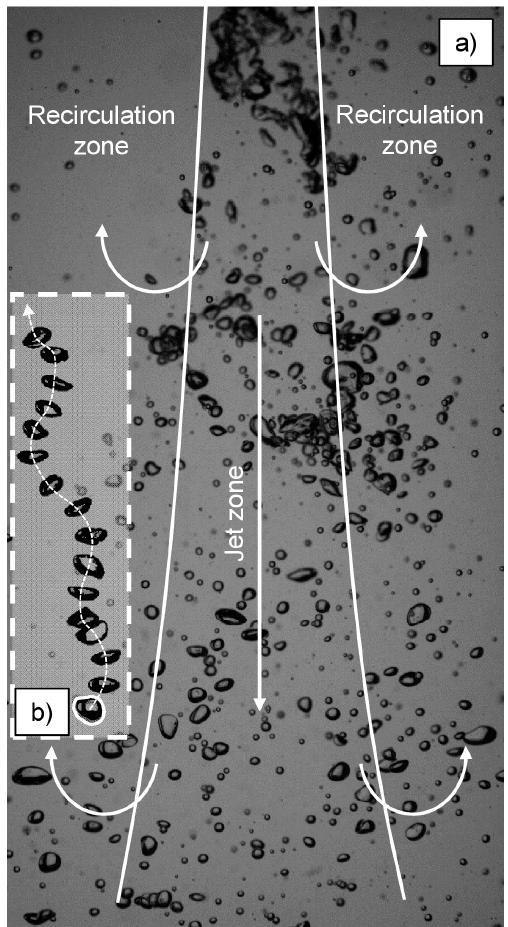
Figure 1. Air bubbles entrained by the vertical plunging jet ( a ); individual air bubble path, rising inside the lateral recirculation zone (only the highlighted bubble is at the same time as the recorded frame) ( b ).